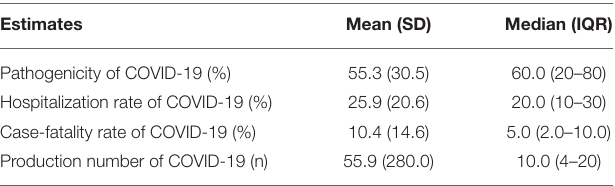
TABLE 4 | Participant’s estimation on pathogenicity, hospitalization rate, case fatality, and production number.